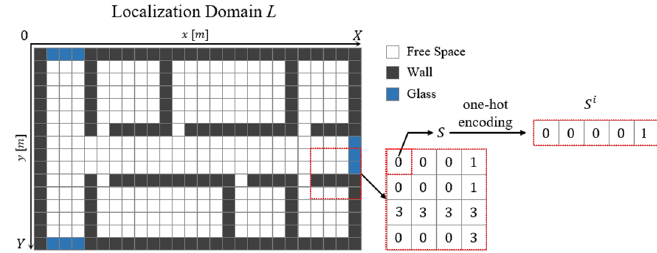
Figure 4. Structure of localization domain.